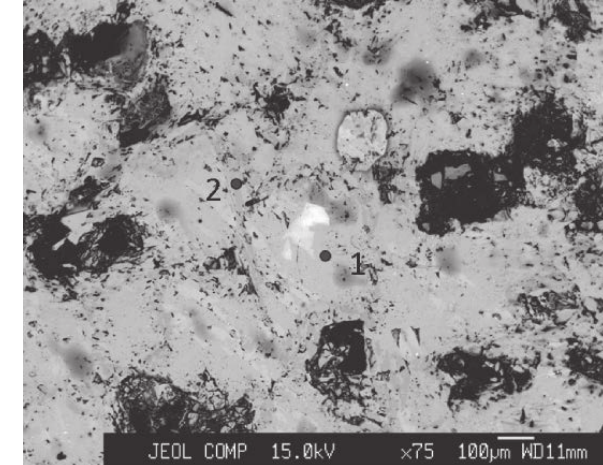
Fig. 5: Backscattered electron micrograph of CMS-F slag. Points: 1 = cuspidine, 2 = merwinite, 3 = monticellite.